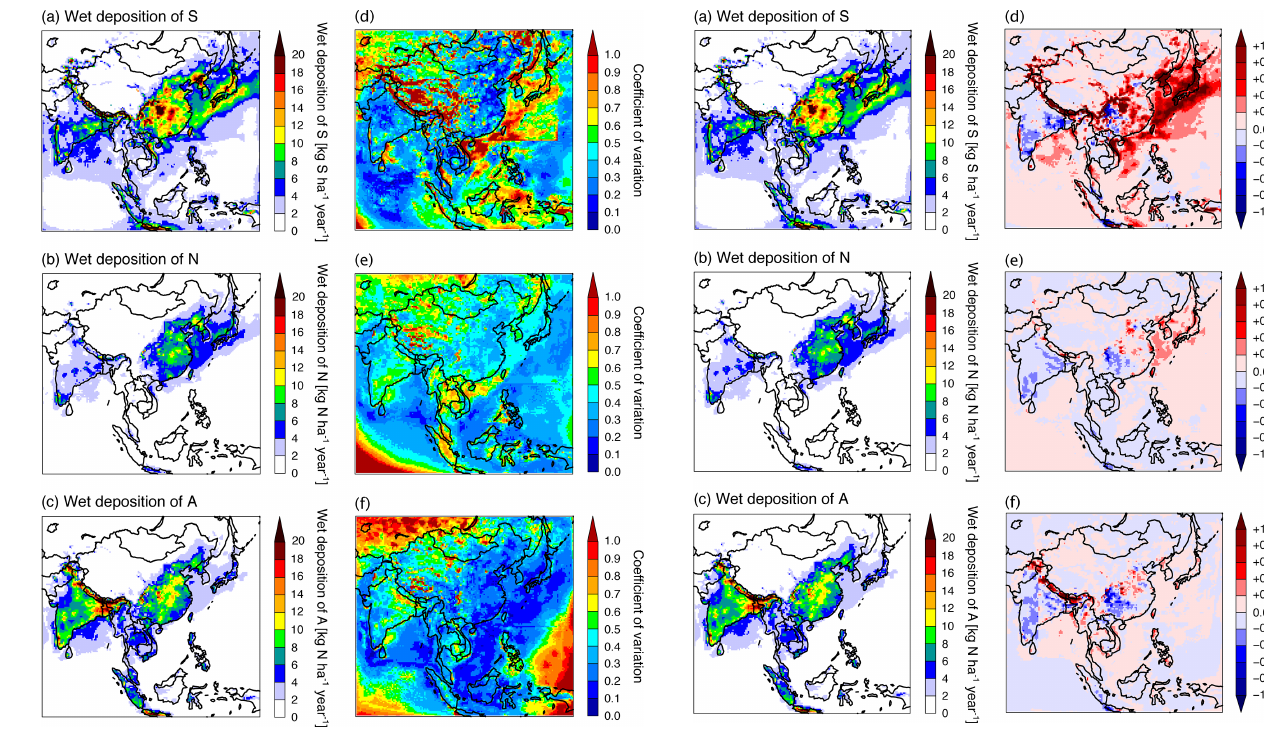
Figure 12. Spatial distributions of the ensemble mean (a–c) and the coefficient of variation (d–f) for the wet deposition of (a) S, (b) N, and (c) A.